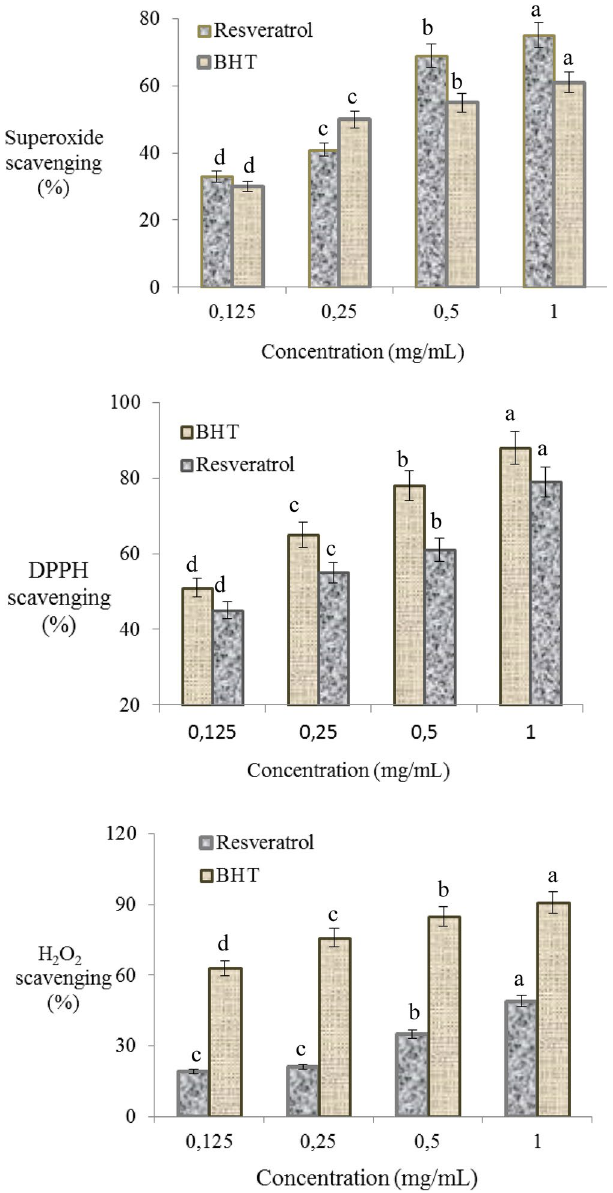
Figure 1. Superoxide, DPPH and H 2 O 2 scavenging property of resveratrol. The experiment was repeated three times at each concentration. Each histogram is a decimal average. The vertical lines on the bars indicate the standard error. Different letters (a–d) indicated averages p < 0.05 is